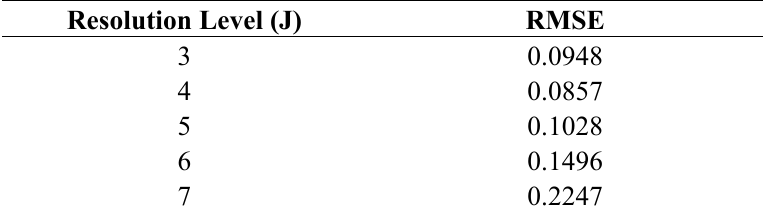
Table 4. RMSE between experimental fluorescence spectrum of 3 components (MLT, PNH and DMLT) and reconstructed signal by DWT with wavelet filter Daubechies 6 and different resolution levels (CR = 5).